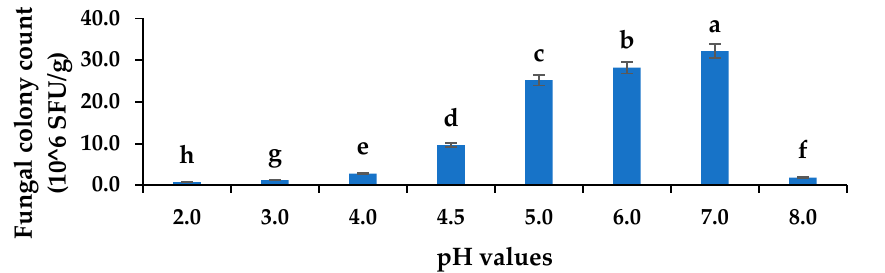
Figure 4. Acid tolerances of C. gloeosporioides at various pH concentrations. Columns with different letters were significantly different at the p ≤ 0.05 level. Keys: SFU/g—spore forming units per gram.